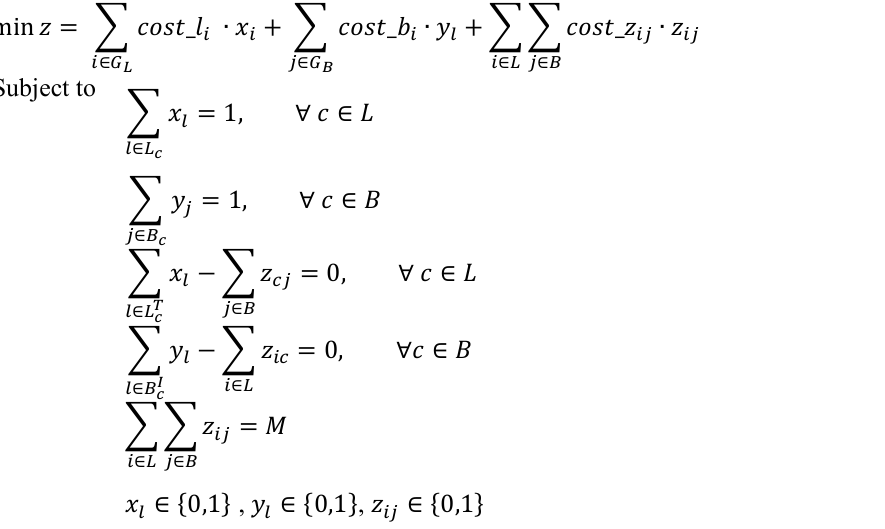
Connections between